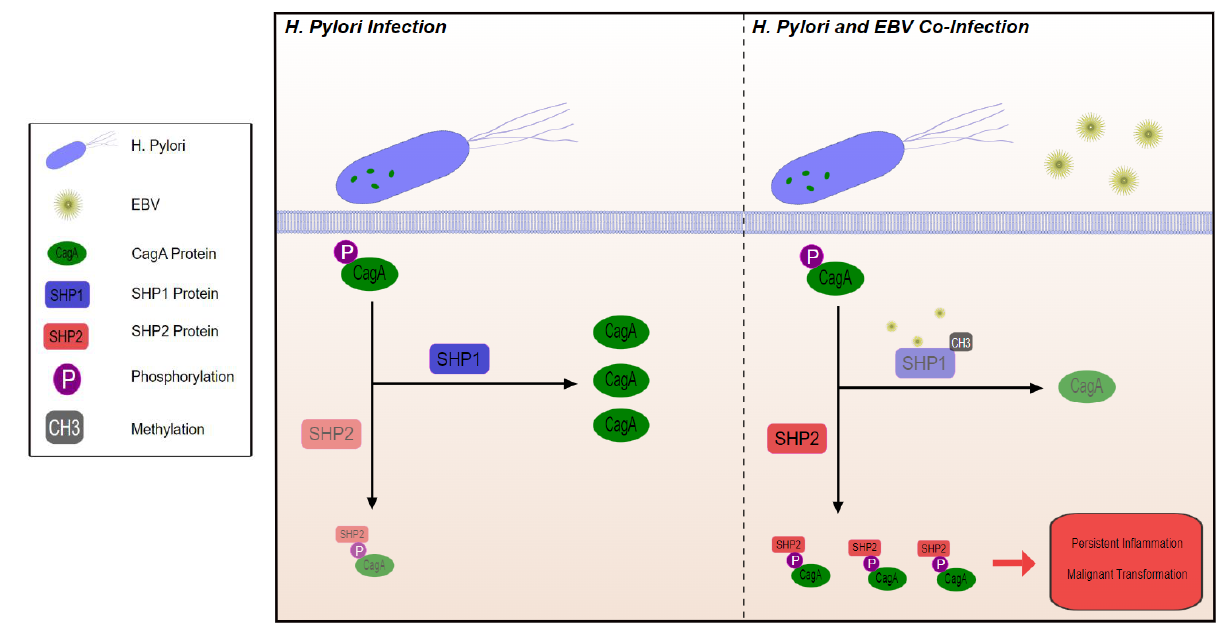
Figure 1. Through methylation and inhibition of SHP1, EBV co-infection with H. Pylori promotes interaction between phosphorylated CagA protein and SHP2 leading to inflammation and malignant transformation.